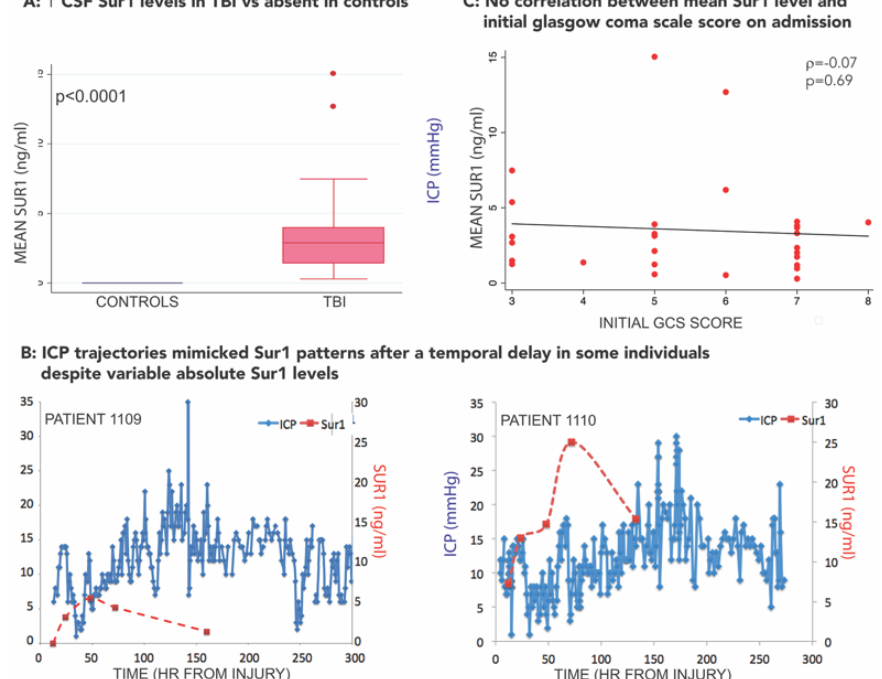
Figure 4. Cerebrospinal fluid SUR1 levels may be a biomarker for secondary injury after traumatic brain injury. ( A ) Box plot demonstrating increased cerebrospinal fluid (CSF) SUR1 levels (ng/mL) in TBI (red) vs. absent in controls. Error bars represent inter-quartile range. Adapted with permission from Jha et al., Sulfonylurea Receptor 1: A Novel Biomarker for Cerebral Edema in Severe Traumatic Brain Injury, Crit Care Med, 45 (3), e255–e264, 2017. ( B ) Temporal graph of SUR1 levels (ng / ml, red line) and intracranial pressure (ICP mmHg, blue line) in two patient examples (#1109, #1110). Here, the ICP trajectory mimics the SUR1 pattern after a variable temporal delay. Adapted with permission from Jha et al., Sulfonylurea Receptor 1: A Novel Biomarker for Cerebral Edema in Severe Traumatic Brain Injury, Crit Care Med, 45 (3), e255–e264, 2017. ( C ) Scatter plot demonstrating no correlation between mean Sur1 level (red dots) and initial Glasgow coma scale score ( x -axis) on admission. Trendline shown in black. Pearson’s rho = 0.07, p = 0.69.